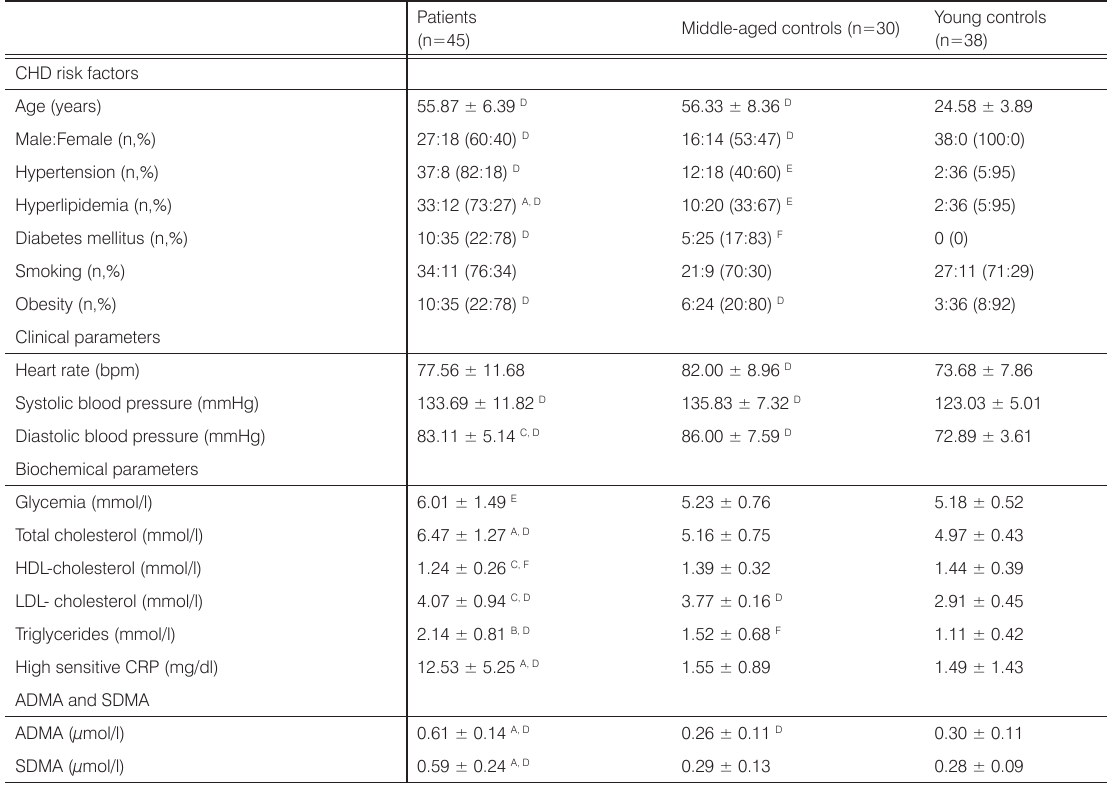
Table 1. Cardiovascular risk factors, clinical and biochemical parameters, ADMA and SDMA.